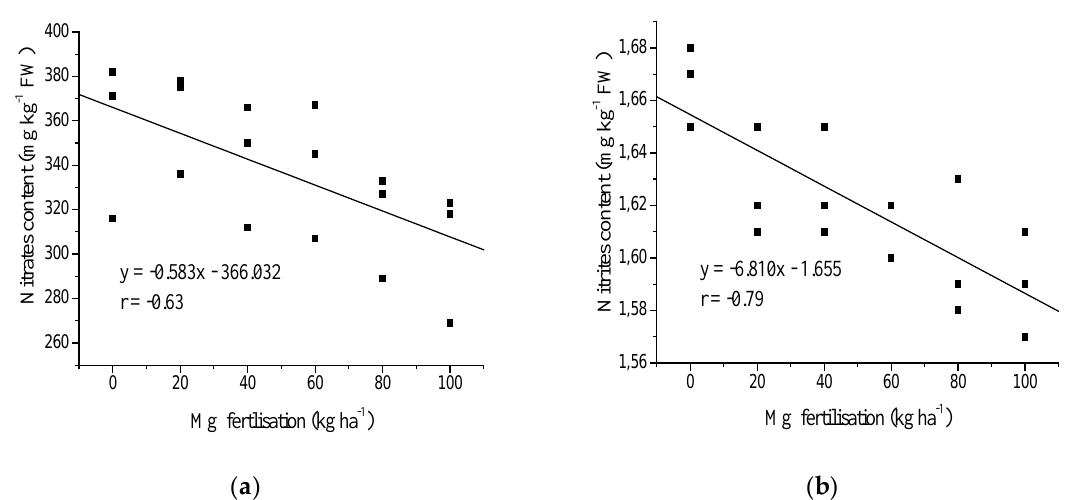
Figure 3. The significant relationship between the dose of magnesium fertilisation and NO 3 − 1 ( a ) and NO 2 − 1 ( b ) contents in the potato tubers after harvest. R: p ≤ 0.05.